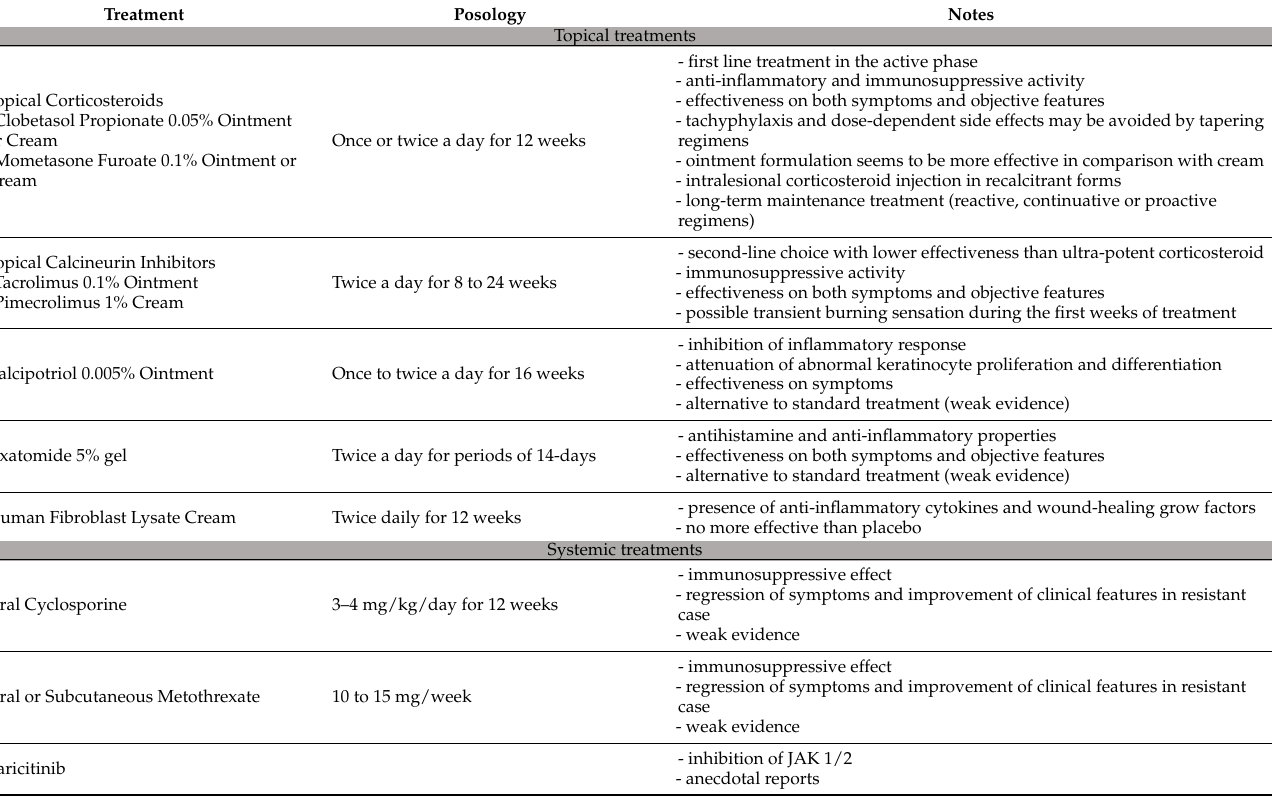
Table A1. Treatments mainly acting on immune dysreactivity and inflammatory